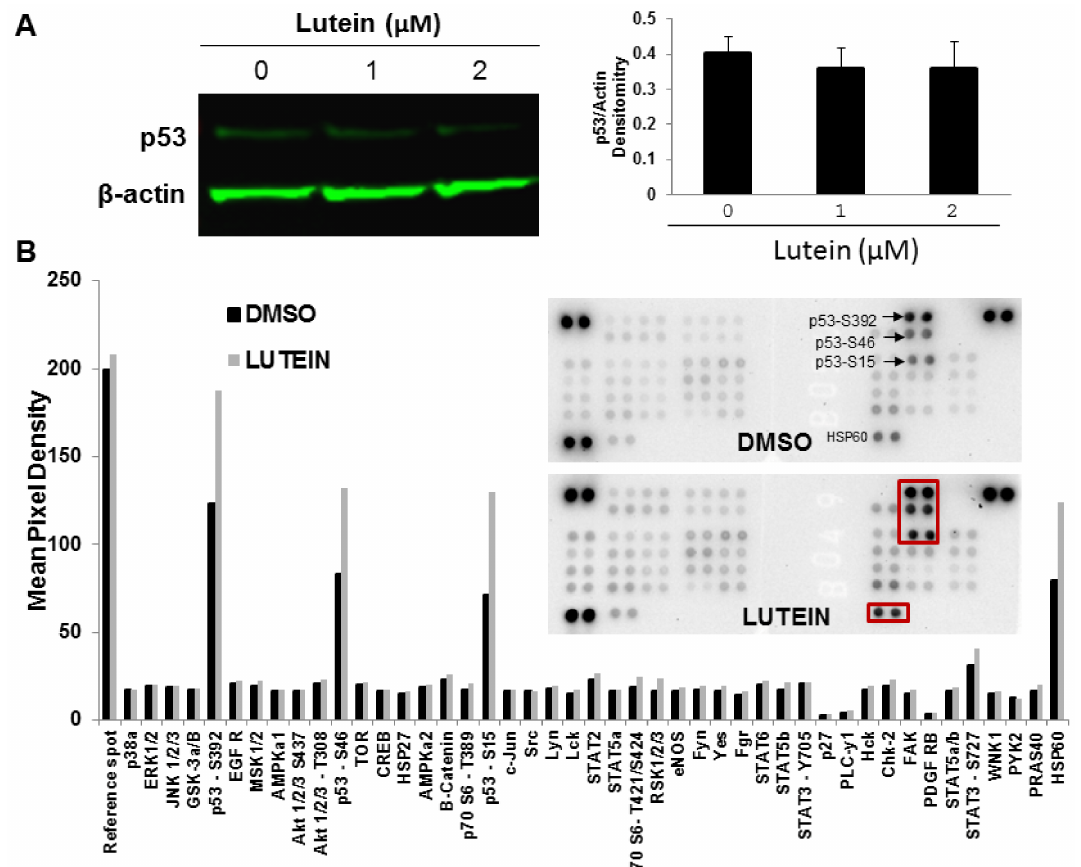
Figure 6. Effect of lutein on phosphorylated signaling proteins in triple-negative breast cancer cells. ( A ) Left panel: Western blot analysis of p53 in MDA-MB-468 cells. Cells were treated with 1.0, or 2.0 µ M lutein or DMSO vehicle control for 24 h. Cell lysates were prepared and subjected to Western blotting for p53. Right panel: the histogram in Figure 6A indicates the average of adjusted p53 levels (mean ± SD, n = 3). ( B ) Analysis of a proteome profiler for human phospho-kinases using breast cancer MDA-MB-468 cell lysates from lutein-treated and DMSO vehicle control. Data represent the densitometric analysis of phosphorylated signaling proteins in MDA-MB-468 cells treated with lutein or control. The insets are the representative proteome profiler from the Human Phospho-Kinase Array using MDA-MB-468 cell lysates treated with 2.0 µ M lutein or DMSO control for 12